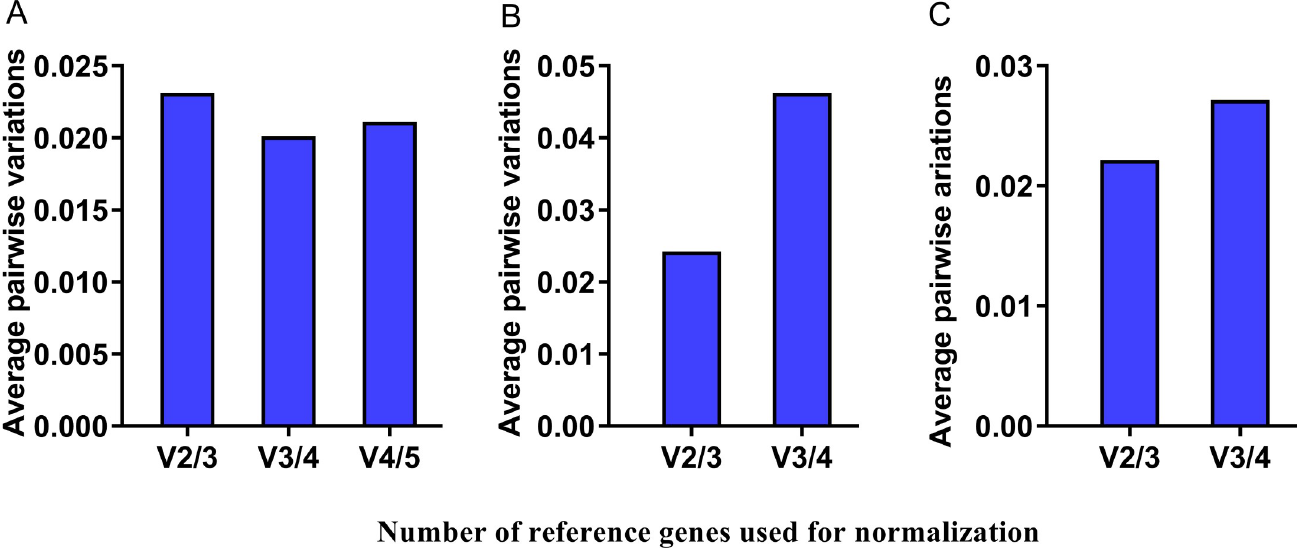
Fig 5. Determination of the optimal number of reference genes for normalization. (A) Developmental stages of G88 strain; (B) Tissues of G88 strain; (C) Tissues of GC strain. Pairwise variations ( V ) were calculated between the normalization factors NF n / n+ 1 reference genes. geNorm decides whether inclusion of an extra reference gene adds to the stability of the normalization factor.